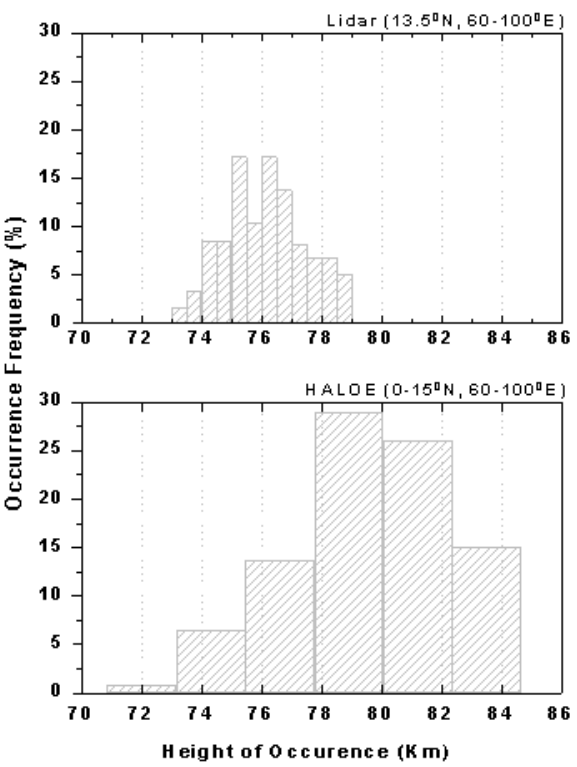
Fig. 7. Mesospheric temperature inversion frequency distribution for height of occurrence over ( a ) Gadanki (13.5 ◦ N, 79.2 ◦ E) ( b ) present work (0–15 ◦ N, 60–100 ◦